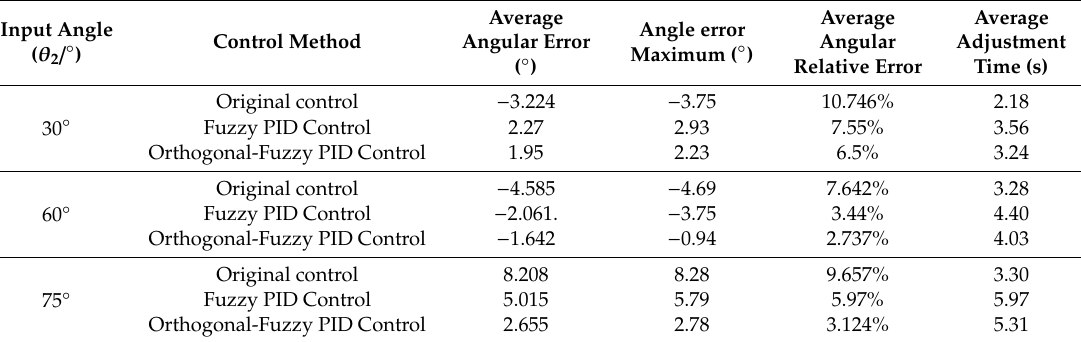
Table 9. Angular error and average adjustment time of the manipulator